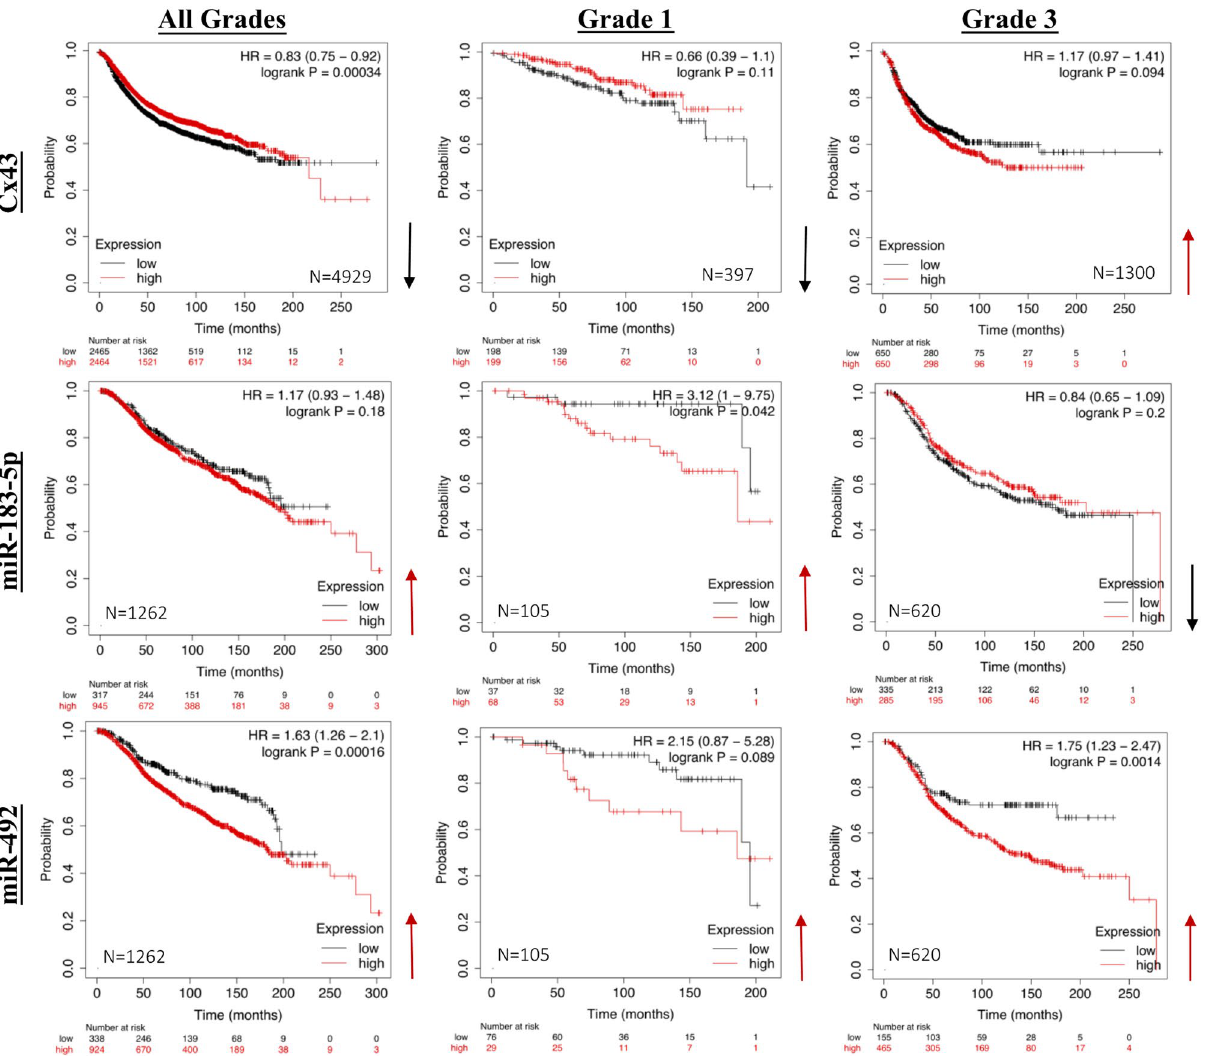
Figure 7. The association of Cx43, miR-183-5p and miR-492 levels with disease prognosis in cohorts of breast cancer patients with low versus high grade tumors. Using all breast cancer mRNA datasets in the Kaplan–Meier Plotter 38,39 , the survival analyses for Cx43 in 4929 patients across all grades, 397 patients with grade 1 and 1,300 patients with grade 3 breast tumors were plotted (upper panel) . Using METABRIC breast cancer miRNA dataset in the Kaplan–Meier Plotter the survival analyses for miR-183-5p (middle panel) and miR-492 (lower panel) in 1262 patients across all grades, 105 patients with grade 1, and 620 patients with grade 3 breast tumors were plotted. Red arrows pointing upwards refer to a possible association between poor prognosis in patients and the up-regulation of the respective mRNA/miRNA levels, while a black arrow pointing downwards refers to a possible association between poor prognosis in patients and the down-regulation of the respective mRNA/ miRNA